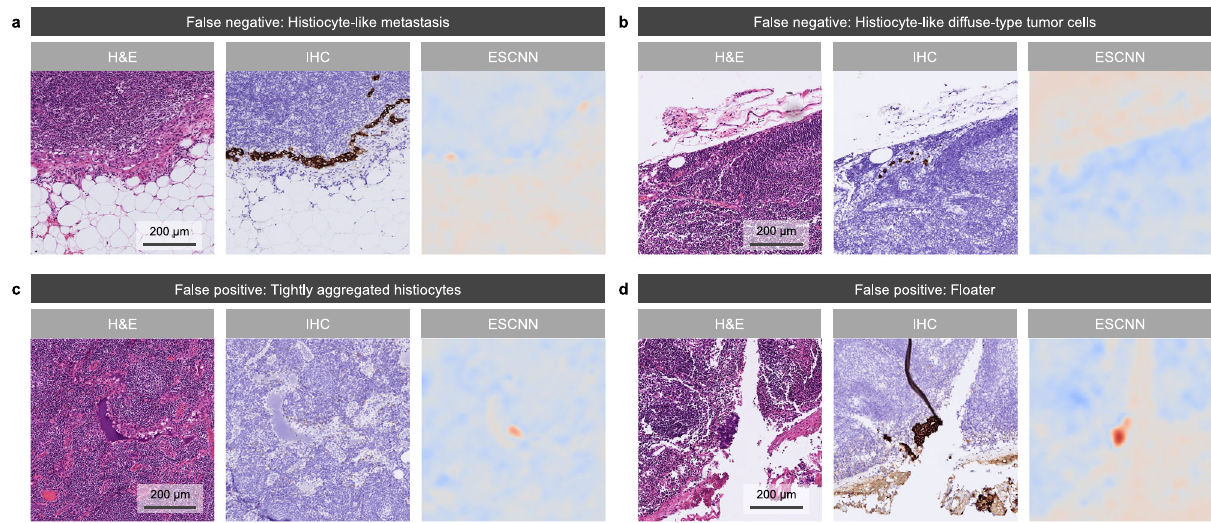
Fig. 5 Qualitative results of lesion highlights on false-negative and false-positive cases. Each panel displays an example of an H&E-stained LN image (left), the reference standard of the metastatic area under IHC staining (cytokeratin AE1/AE3; middle), and the heat map for lesion localization generated by our model through CAM. a Example of false-negative cases indicating histiocyte-like metastasis, which tended to mislead our model. The main test set contained 10 similar samples. b Histiocyte-like diffuse-type ITCs in sinusoids were challenging for both the model and the pathologists; their accurate detection may require IHC slides. c Slide showing histiocytic aggregates in sinusoids and unusual blue proteinaceous fl uid that caused our model to issue a false alarm, which led fi ve of the six pathologists to incorrectly interpret the slide as positive. The incorrect highlight of histiocytic aggregates appeared in three samples. d Floater misidenti fi ed by our model and fi ve of the six pathologists under AI assistance as metastatic adenocarcinoma. Five slides with artifacts (including cautery, crushing, and fl oater artifacts) were misidenti fi